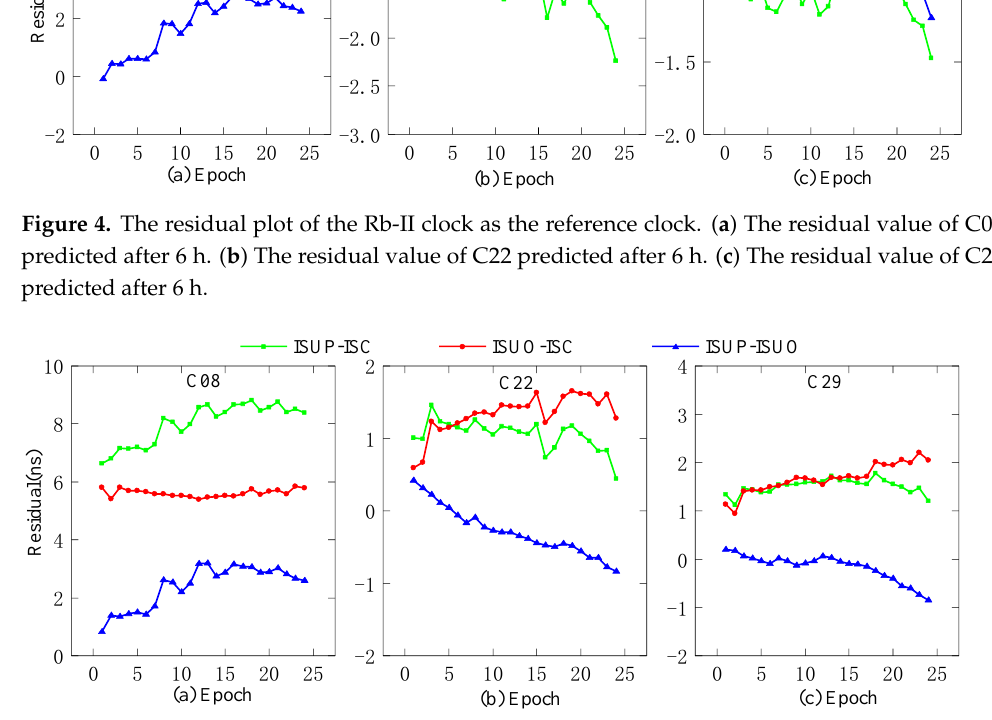
Figure 5. The residual plot of the PHM clock as the reference clock. ( a ) The residual value of C08 predicted after 6 h. ( b ) The residual value of C22 predicted after 6 h. ( c ) The residual value of C29 predicted after 6 h.